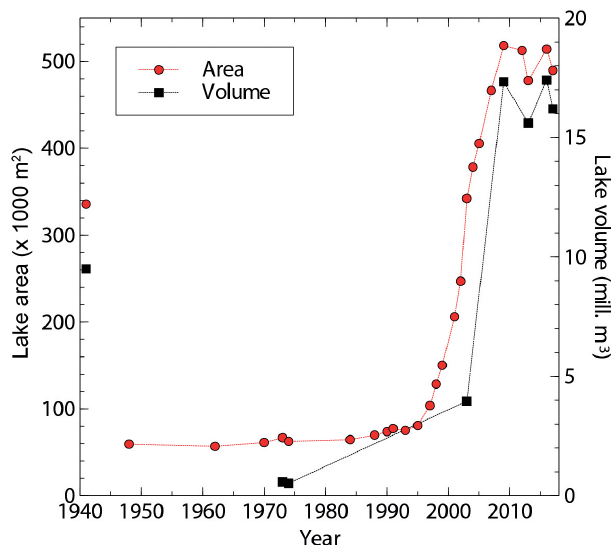
Figure 3. Evolution of area and volume of lake Palcacocha from 1941 to present (data sources: see Table